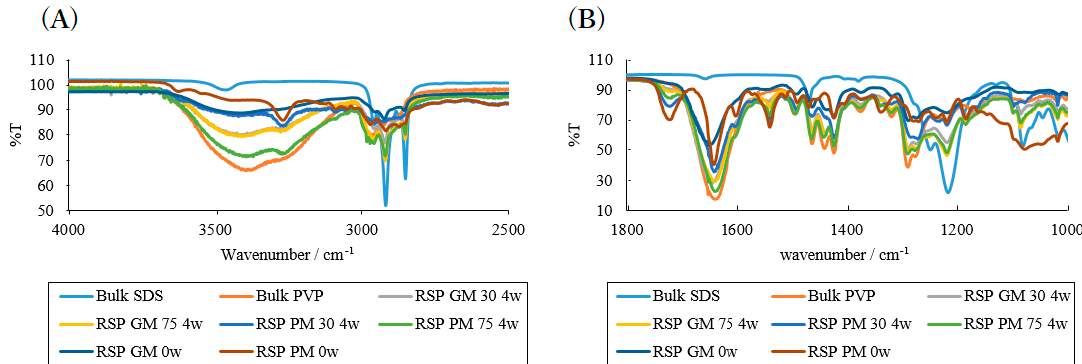
Figure 6. Attenuated total reflection-mid-infrared spectra of bulk SDS, bulk PVP and stored RSP samples. RSP samples, bulk SDS and bulk PVP samples were stored in RH 30% and RH 75%. Bulk RB sample was stored for 4 weeks in RH 30% and RH 75%. The two regions of 4000 to 2500 cm − 1 ( A ) and 1800 to 1000 cm − 1 ( B ). RH; relative humidity. RB; rebamipide. SDS; sodium dodecyl sulfate. PVP; polyvinylpyrrolidone. w; weeks.